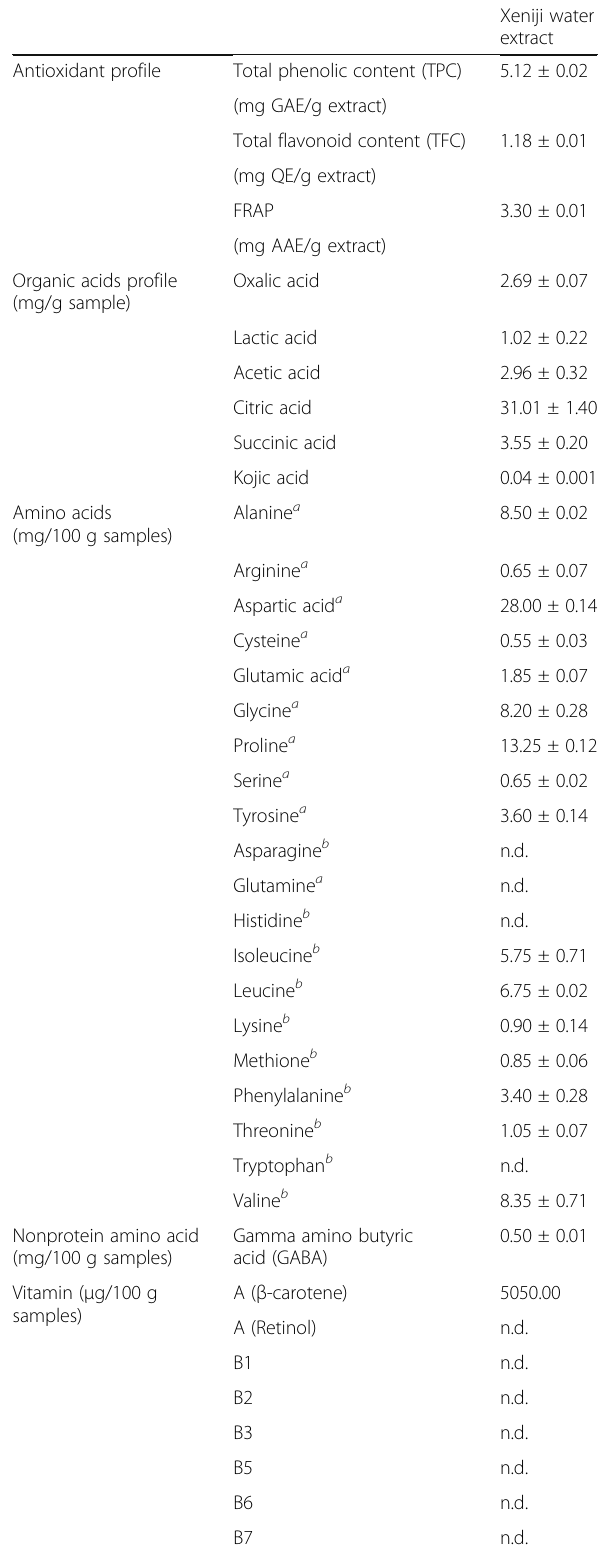
Table 4 Antioxidant, organic acids and amino acids profiles of Xeniji Xeniji water extract